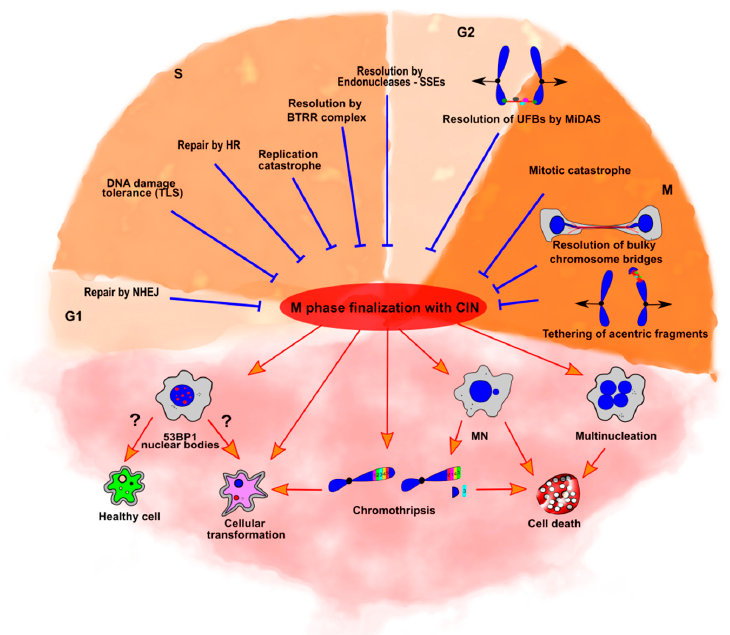
Figure 2. Mechanisms that inhibit or promote chromosome instability (CIN). Top (blue lines): Mechanisms involved in inhibiting or restraining CIN during the different cell cycle stages. Non-homologous end joining (NHEJ) can be utilized throughout the cell cycle but is required for double-strand break (DSB) repair in G1 phase due to the absence of homologous recombination (HR). Translesion synthesis (TLS), HR, and multiple endonuclease-dependent mechanisms, such as the BTRR complex and structure-specific endonucleases (SSEs), can prevent the accumulation of CIN during mitosis. DNA bridge resolution and mitotic DNA synthesis (MiDAS) during M phase can resolve multiple types of DNA bridges. Broken chromosome fragments can be incorporated in M phase via chromosome tethering mechanisms. Replication or mitotic catastrophe in S or M phase, respectively, when exacerbated, usually leads to cell death, thus preventing the accumulation of cells with CIN. Bottom (orange arrows): Cells that enter mitosis with chromosome abnormalities due to failed repair mechanisms present alternative mechanisms of resolution that can potentiate CIN and carcinogenesis, such as micronuclei (MN) breakage via chromothripsis. Some forms of DNA damage lead to 53BP1 nuclear bodies, whose implications are still largely unknown. In contrast, some MN or gross mitotic abnormalities, such as multinucleation, can lead to cell